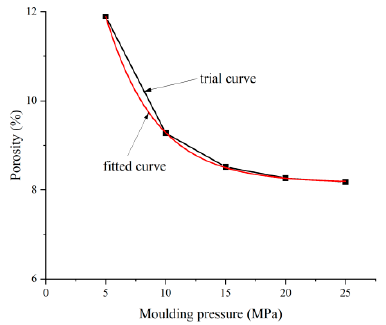
Figure 7. Effects of molding pressure on porosity.